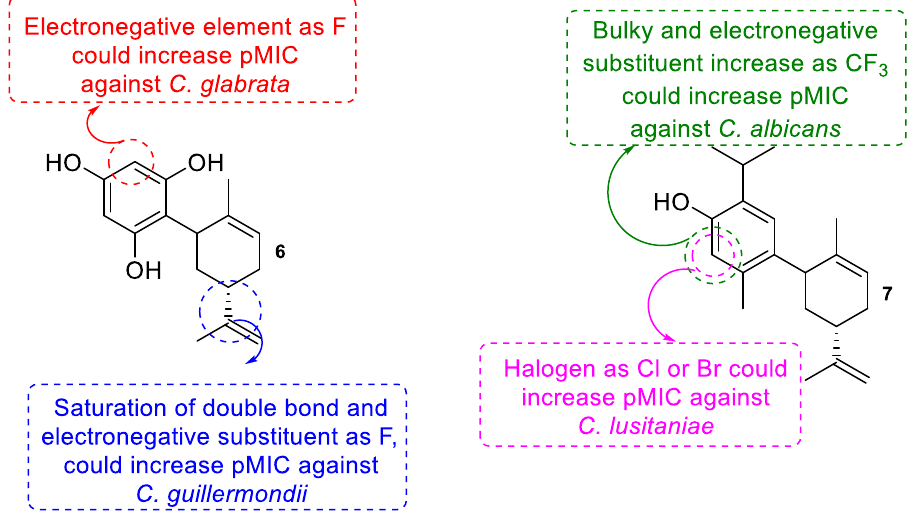
Figure 2. Summary of potential structural modifications to increase the antifungal activity of derivatives 6 and 7 against different strains of Candida sp.